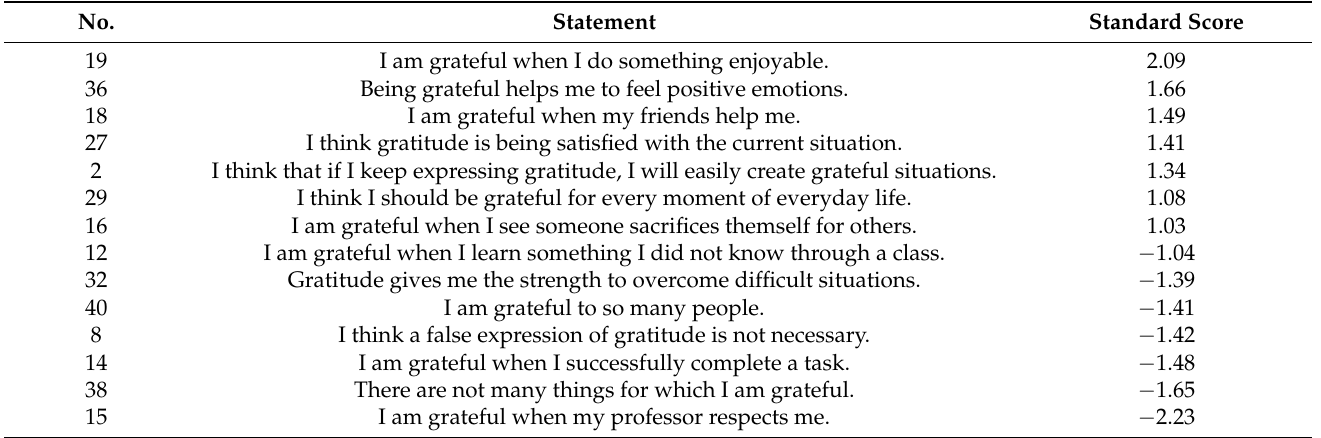
Table 10. Statements and Standard Scores (at least ± 1.00) of Type